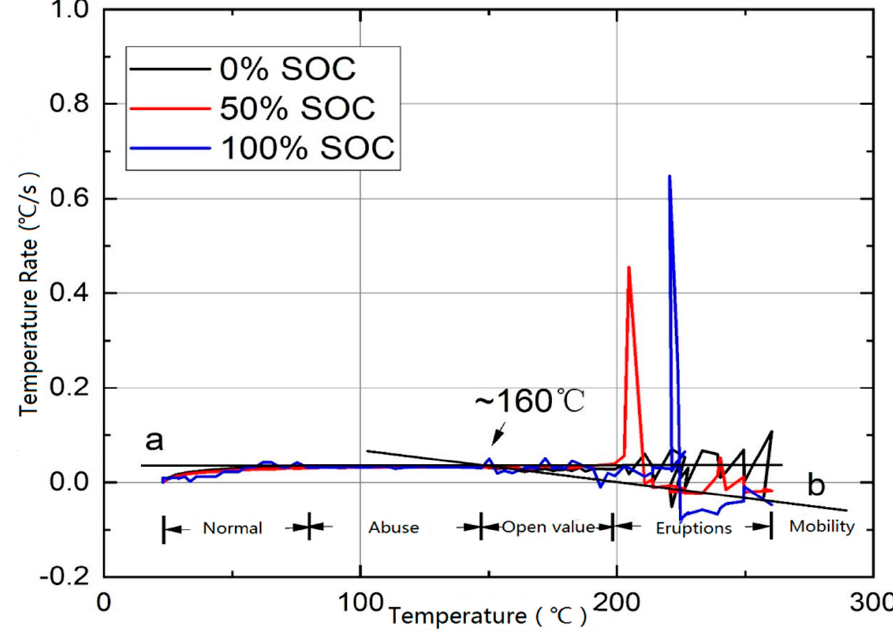
Figure 5. Temperature rate of the cell versus cell temperature. The stages of thermal runaway are divided. The thermal runaway behavior of the battery is divided into several phases depending on the variation in temperature rise rate. The thermal runaway reaction begins at the point where the two lines intersect, which is roughly 160 °C.